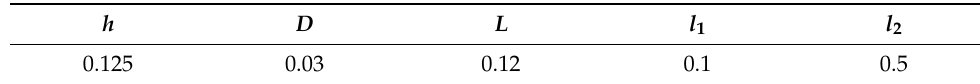
Figure 1. Analyzed model of cavity with probe locations. Table 1. Dimensions of the model (in meters).